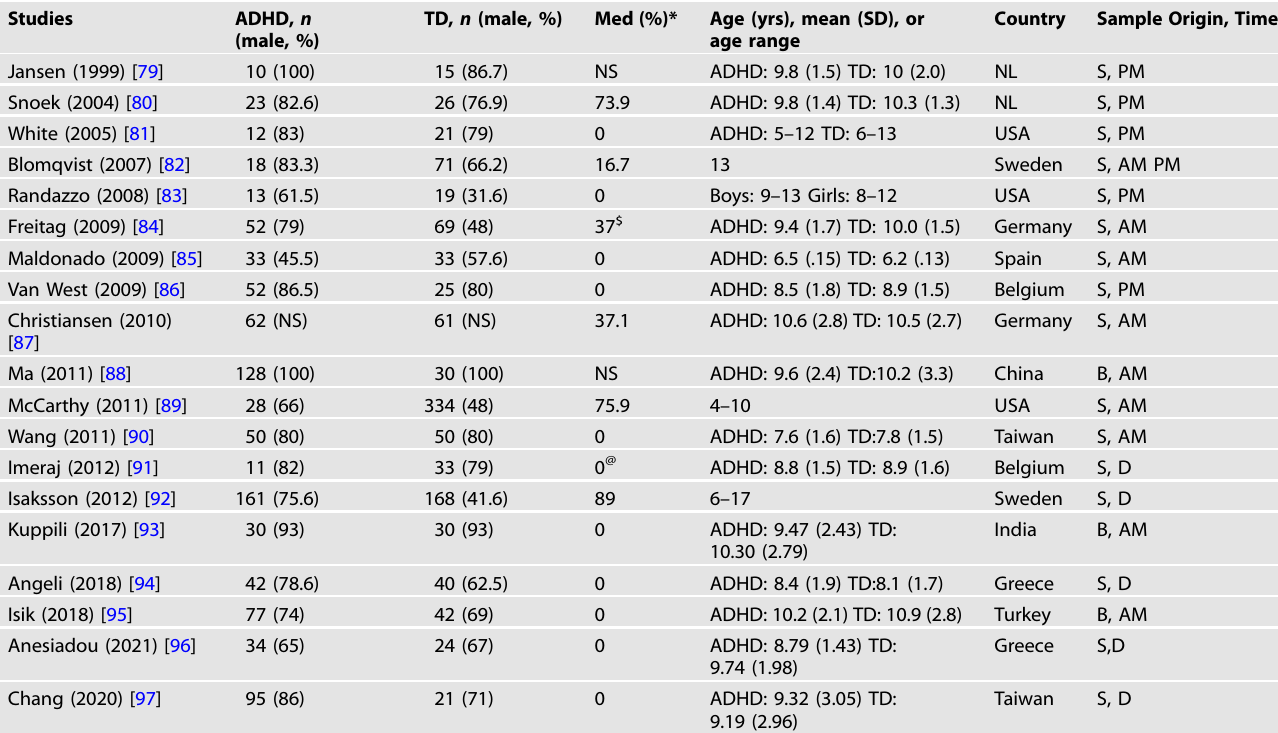
Table 1. Characteristics of Studies Included in the Meta-Analysis for Cortisol Levels in Children with ADHD.